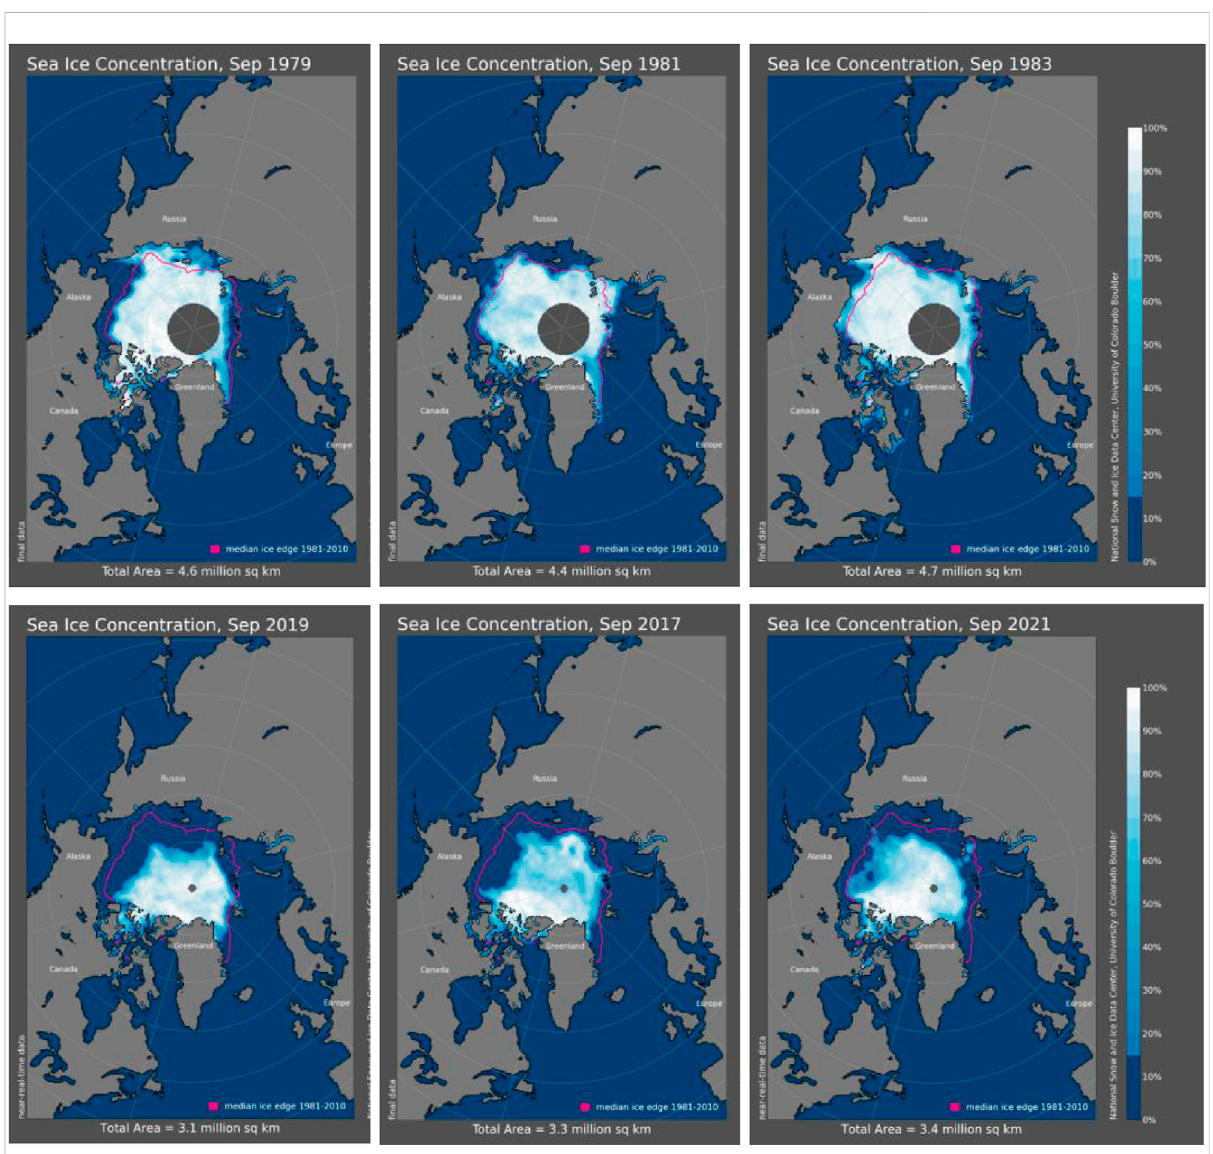
FIGURE 10 Arctic sea ice concentrations in September for 1979, 1981, and 1983 (upper row) compared to the years 2017, 2019, and 2021 (lower row). The pink line demarks the median sea ice edge over the time period 1981 – 2010. The total sea ice area has decreased by around 25% between these two time periods. Images are obtained from the National Snow and Ice Data Center (Fetterer et al.,